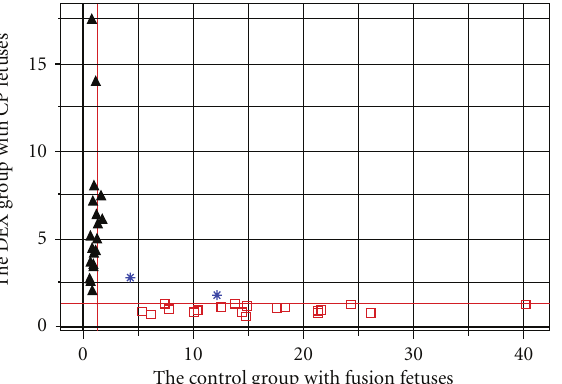
Figure 5: The Cooman’s plot of two groups in test set from SIMCA. “ (cid:2) ” showed the DEX group with CP fetuses; “ (cid:3) ” showed the control group with fusion fetuses; “ ∗ ” showed two outlier samples (pregnant mice with CP fetuses in control group); the red lines indicate the D-Crit (0.05) level; two groups were located in two di ff erent spaces; the outliers not belong to either